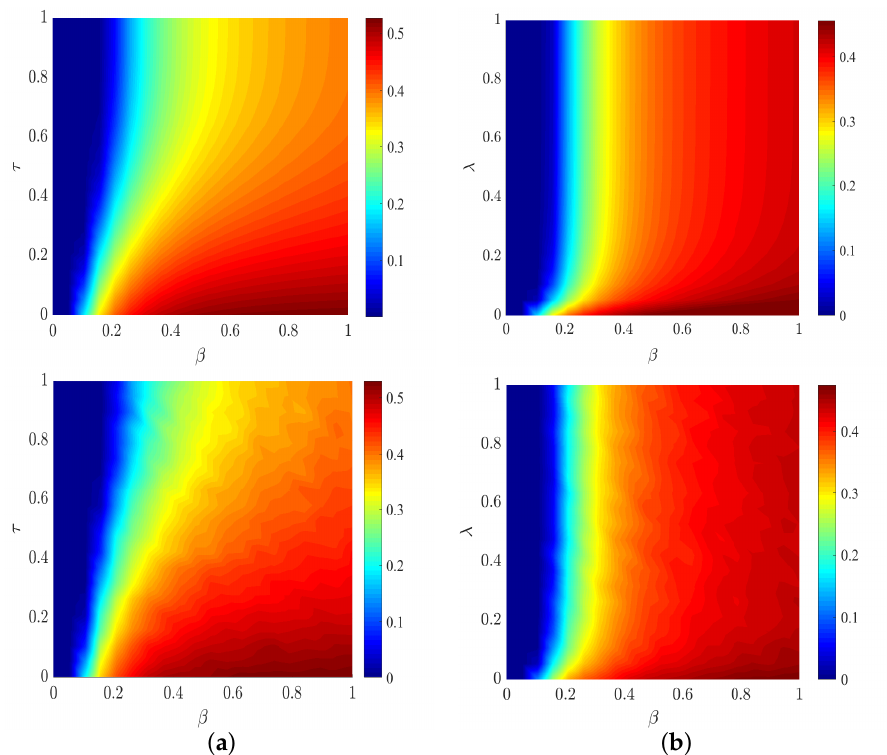
Figure 5. Phase diagrams of the group-based coupled propagation processes on the plane of β − τ ( a ) and β − λ ( b ), where the results in the top panels are obtained by MMCA and those in the bottom panels are obtained by MC. For ( a ), other parameters are set to γ = 0.1, µ = λ 1 = η = 0.9, ι = 1.1, β = δ = λ 2 = 0.5, ¯ x = ¯ y = 3. For ( b ), the parameter values are τ = 0.5, λ = λ 1 = λ 2 , and others are the same as those of ( a